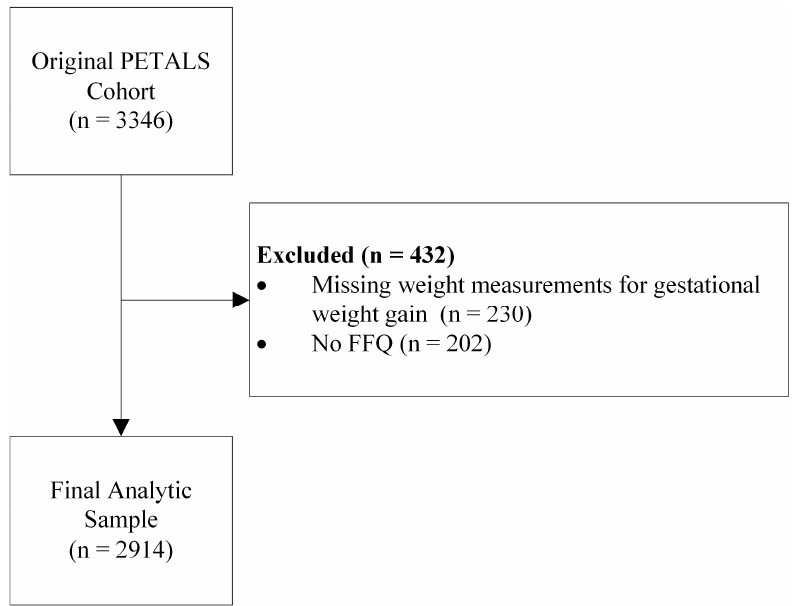
Figure 1. Flow diagram for primary analysis cohort.